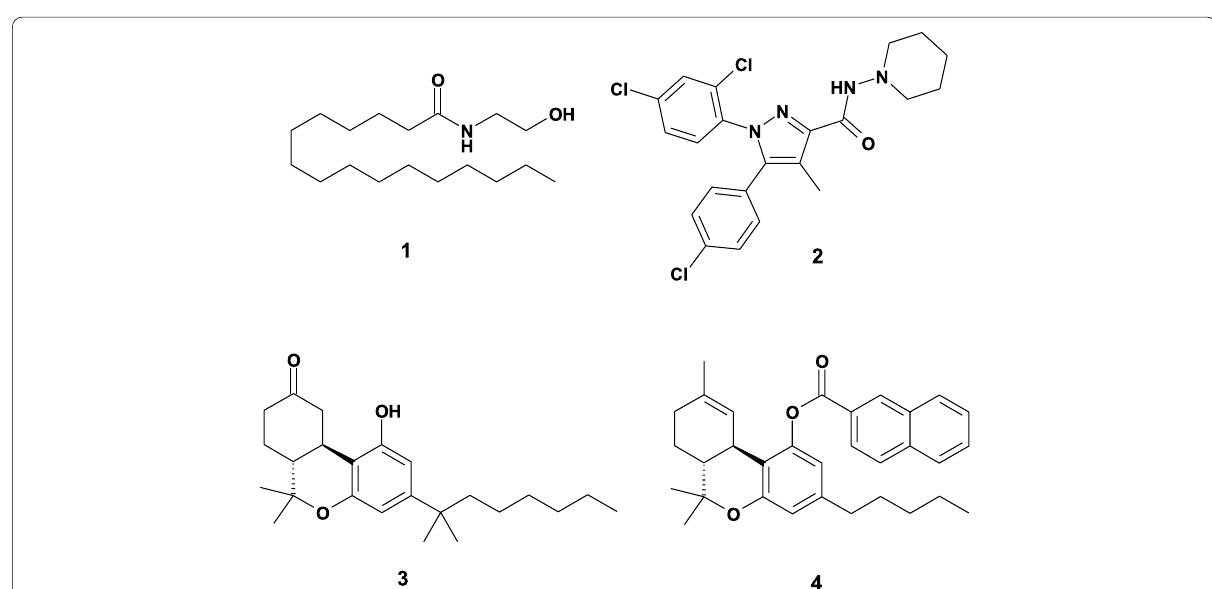
Fig. 2 Cannabinoid associated substances exhibiting crystal